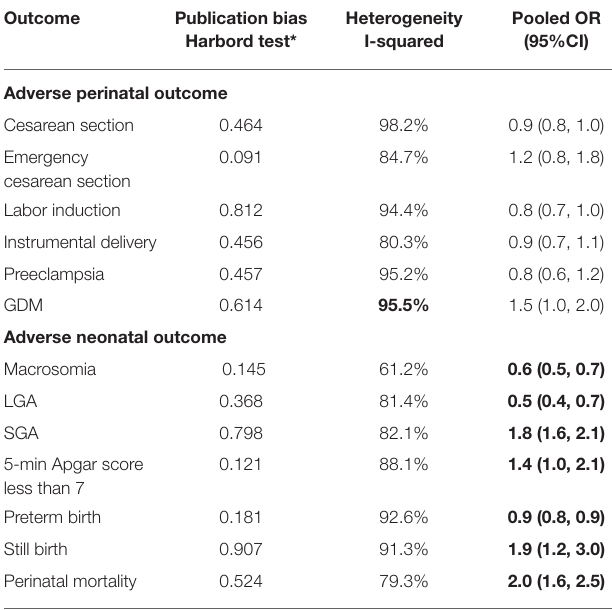
TABLE 2 | Heterogeneity, estimation of publication bias, and meta-analysis of the included studies on the prevalence of adverse maternal and neonatal outcomes.